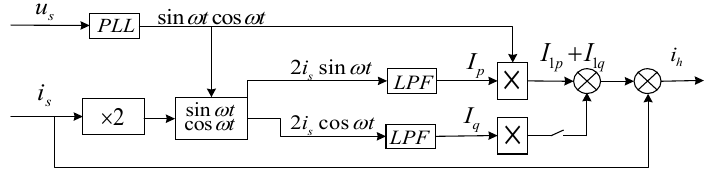
Figure 1. Harmonic and reactive current detection principle.